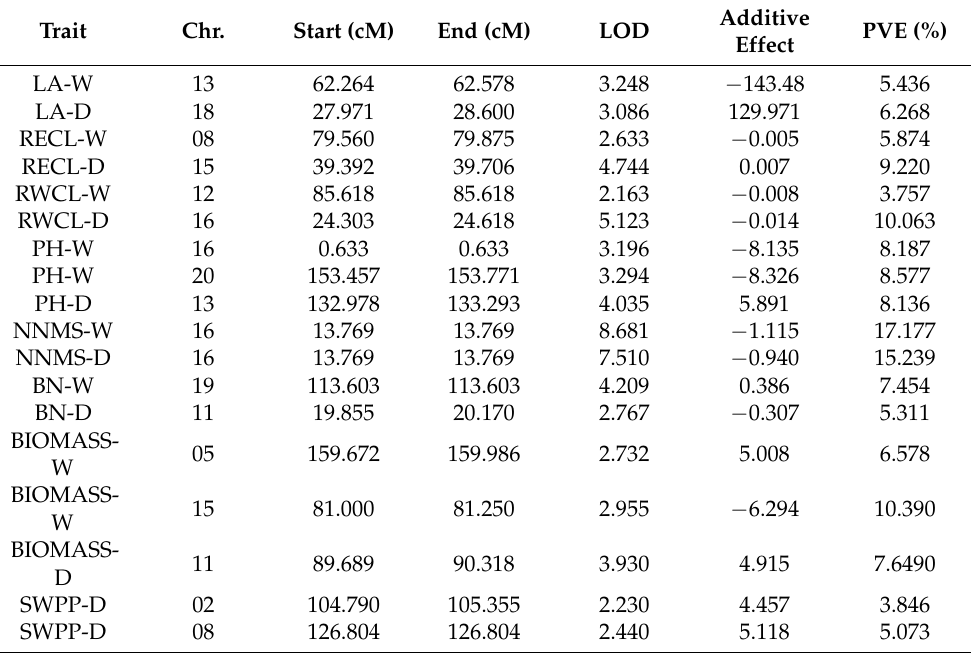
Figure 4. High-density linkage mapping of soybean RIL populations constructed by bin markers. Table 2. Location and description of QTLs in RILs population derived from Jindou21 × Zhongdou33 grown under well-watered control (C) and drought stress (D)